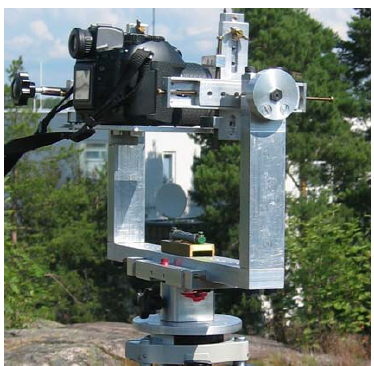
Figure 1. In order to create a measureable panoramic image, a concentric image acquisition was ensured with a calibrated camera